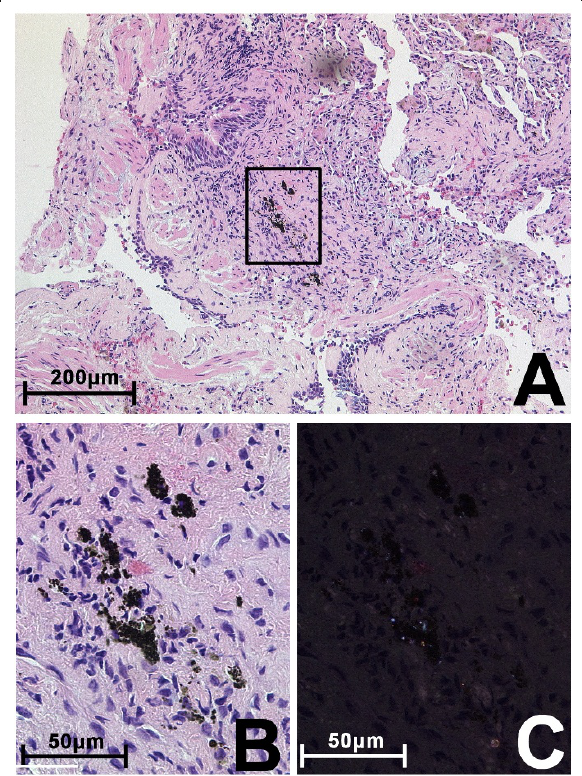
Figure 2 Lung biopsy showing interstitial accented chronic inflammation and anthracotic pigment containing fine birefringent material . A : Overview, HE staining. Scale bar = 200 μ m, enlarged area highlighted (black box). B : Enlargement of A showing the anthracotic pigment and surrounding reactive tissue, scale bar = 50 μ m. C: Same area as B illuminated by polarised light: Bright deposits of birefringent materials and dimly glowing collagen